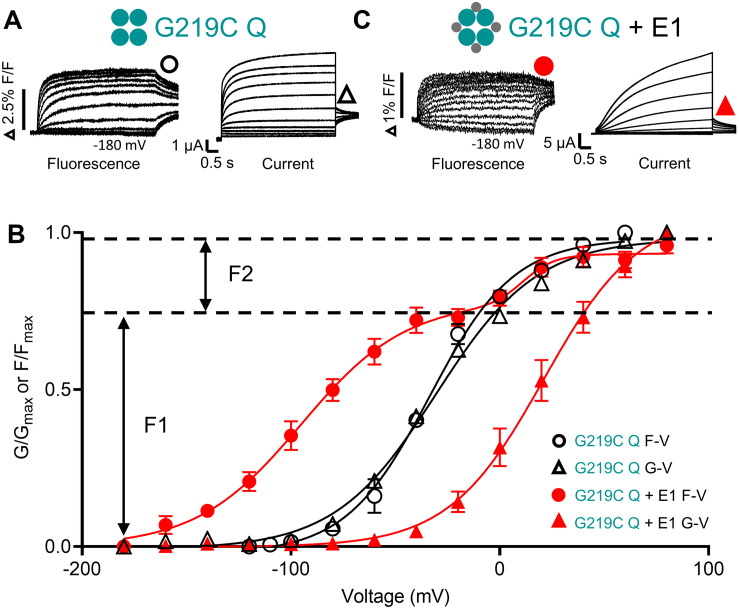
Voltage sensor movement (F-V) and pore opening (G-V) of KCNQ1 in the absence and presence of KCNE1. Fluorescence (left) and current recordings (right) are shown for G219C-KCNQ1 in the absence (G219C Q) (A) and presence of KCNE1 (G219C Q + E1) (B). Expected channel Q1 and E1 complex topologies shown as large and small filled circles, respectively. A three-step protocol was used for current and fluorescence: 4 s pre-pulses to –140 mV (not shown), followed by 5 s steps to potentials between +80 and –180 mV, with a final repolarization step to –40 mV for 1 s. (C) Mean G–V and F–V plots obtained in the absence (G219C Q F-V: black circles; G219C Q G-V: black triangles) and presence of KCNE1 (G219C Q + E1 F-V: red circles; G219C Q + E1 G-V: red triangles). The G219C Q + E1 F-V was fit with a double Boltzmann function to obtain F1 and F2 components. Other F-V and G-V curves were fit with a single Boltzmann function. Fluorescence and current data were replotted from Westhoff et al. (2019), Figure 8 with permission.